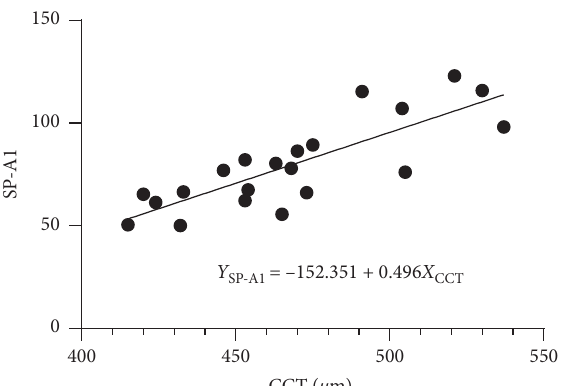
Figure 4: Stiffness parameter at the first applanation (SP-A1) as a function of central corneal thickness (CCT) in post-LASIK ectasia patients (linear regression, F � 37.760, R 2 � 0.665, p ≤ 0 .